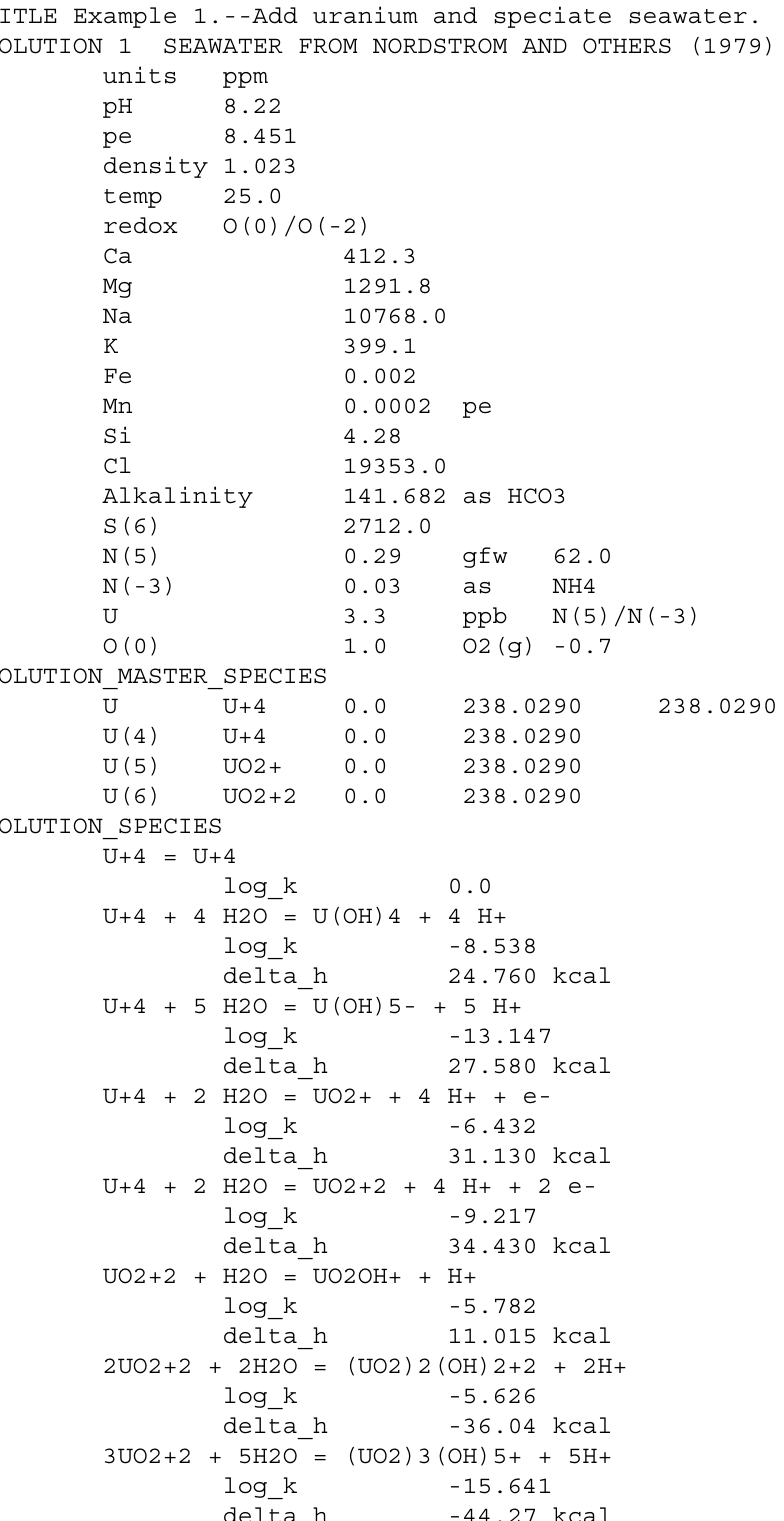
Table 11. Output for example 1.—Continued TITLE Example 1.--Add uranium and speciate